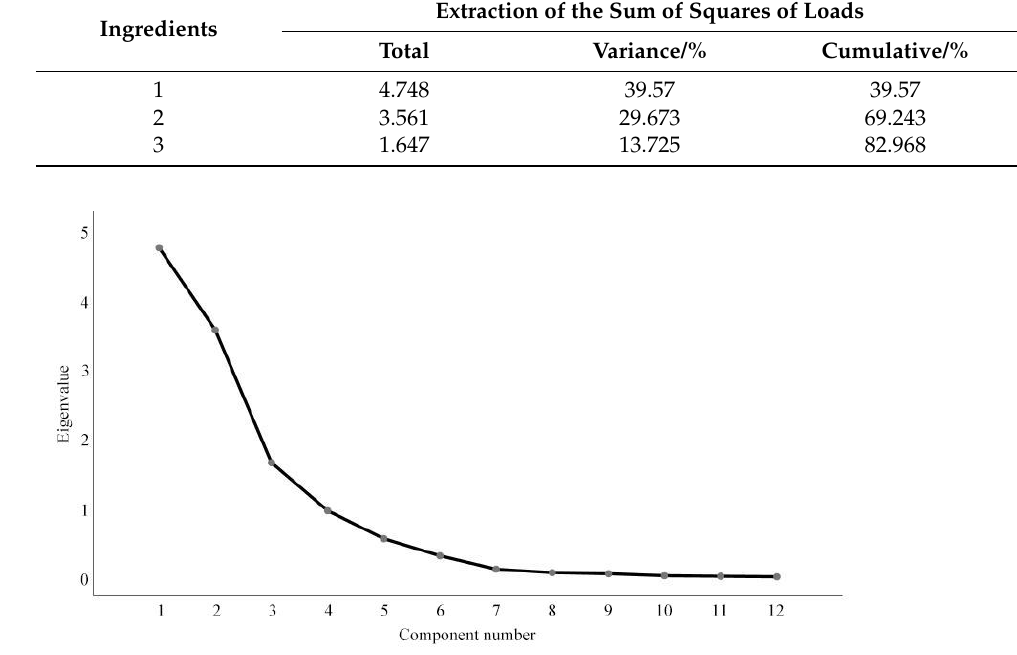
Figure 6. Imagery factor eigenvalue gravel plot.